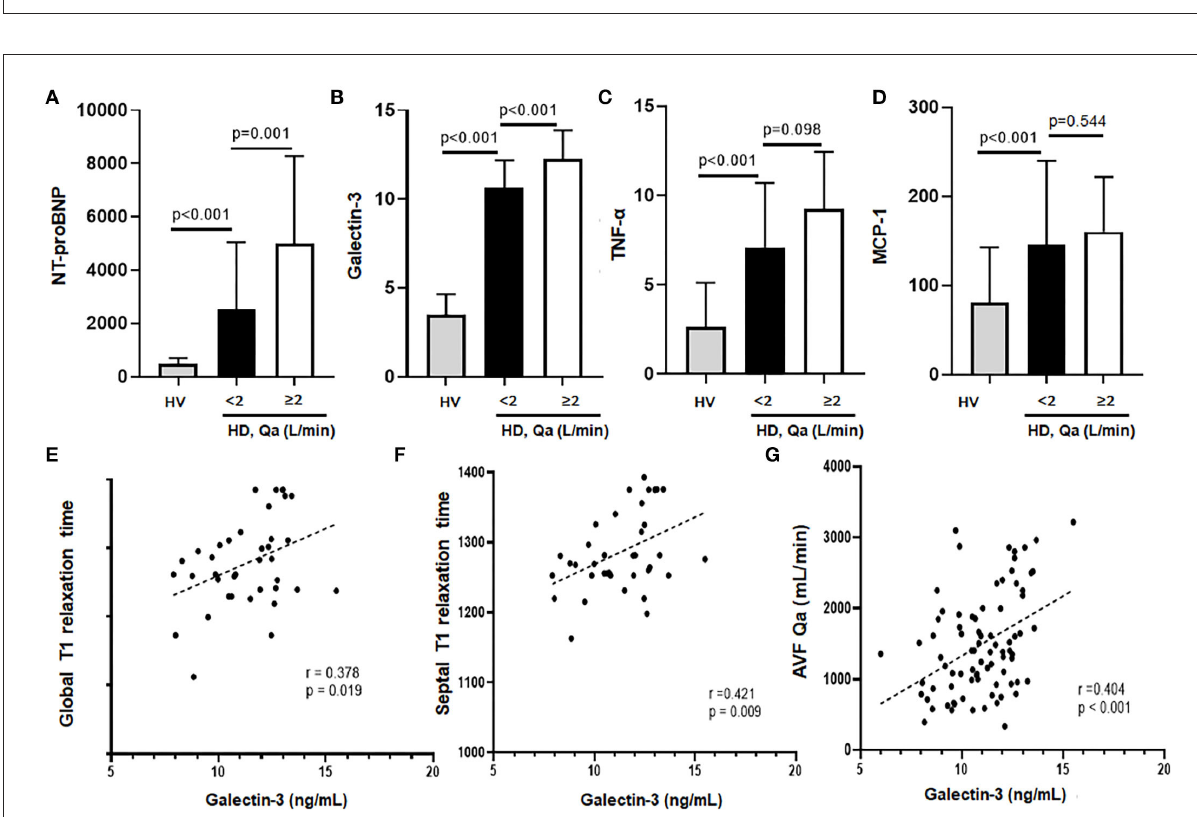
FIGURE3 (A–D) NT-proBNP, galectin-3, TNF- α , and MCP-1 levels of HD patients vs. HV. All the markers were significantly higher in HD patients compared to HV. In addition, HD patients with a high Qa showed a much higher levels of NT-proBNP and galectin-3 levels compared to HD patients with